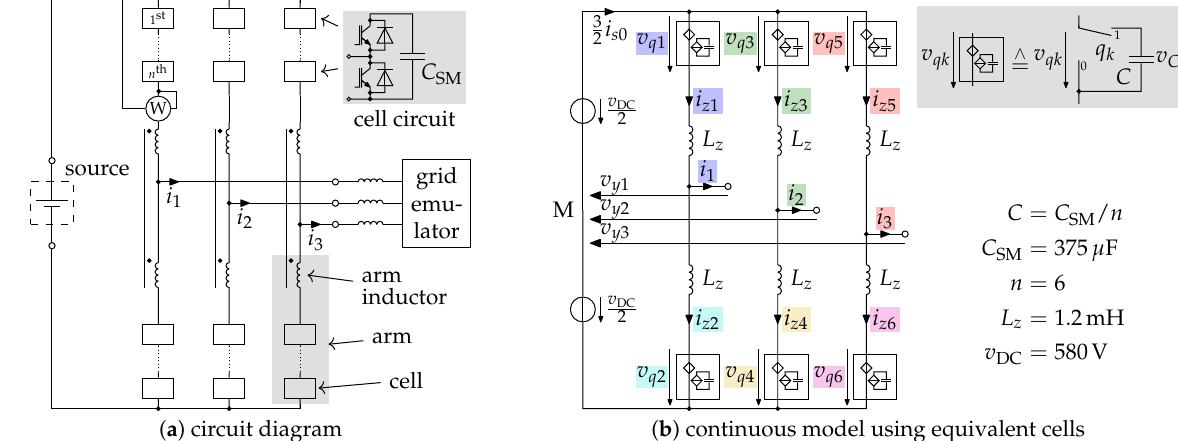
Figure 1. Three phase MMC: ( a ) circuit, and ( b ) continuous model. The cells of each arm are represented by equivalent cells [ 0,1 ] , k = 1, . . . ,6 are used as control and their duty cycles q k ∈